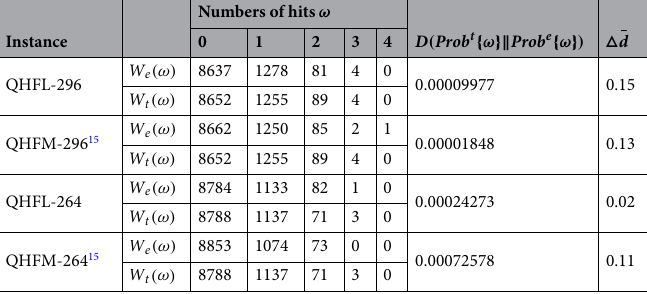
Table 1. Collision resistance test